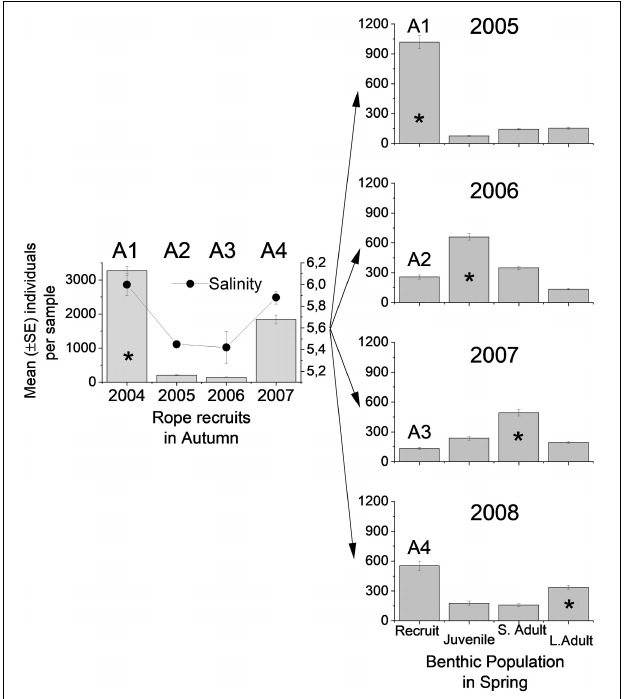
FIGURE 3 | Mean abundance of different mussel size classes ( ± SE) during four years. Left panel shows recruit abundance on artificial units (ropes) in autumn 2004–2007 and mean ( ± SE) summer salinity. Right panel shows the structure of the benthic population during 4 years, sampled in spring each year 2005–2008. The star exemplifies how the recruits of 2004 have traveled through the different cohorts. A1–A4 combine the left and right panel and visualizes how similar the recruitment pulses were on the collectors and in the